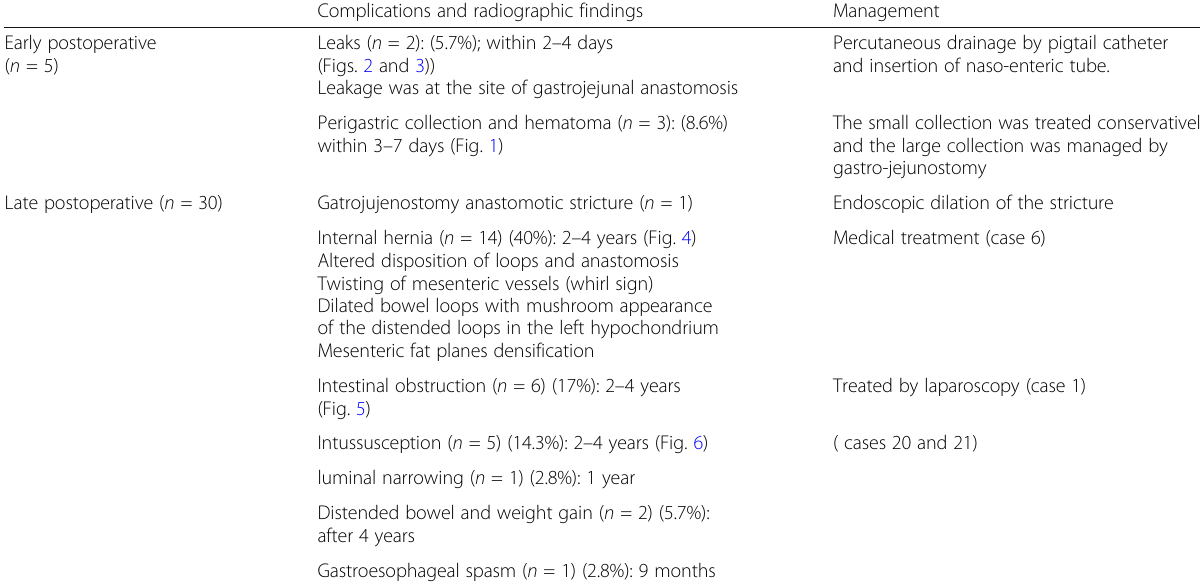
Table 2 Complications of Roux-en-Y gastric